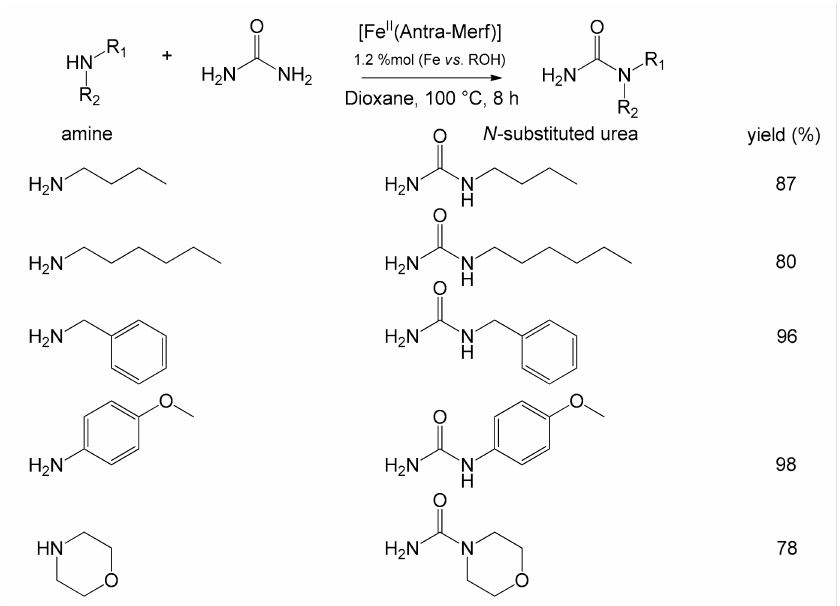
Figure 13. Reaction scheme between urea and differently substituted amines with the catalyst [Fe II (Antra-Merf)] yielding N -substituted ureas